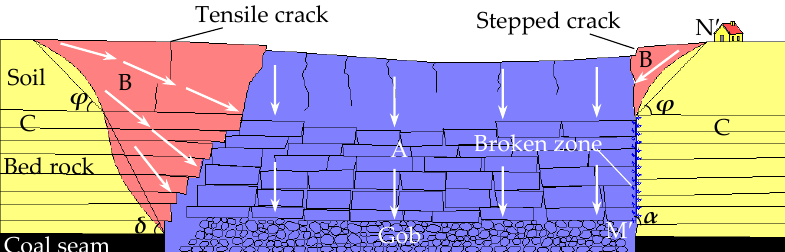
Figure 4. Horizontal zoning of overlying strata movement above the gob under the influence of weak planes.